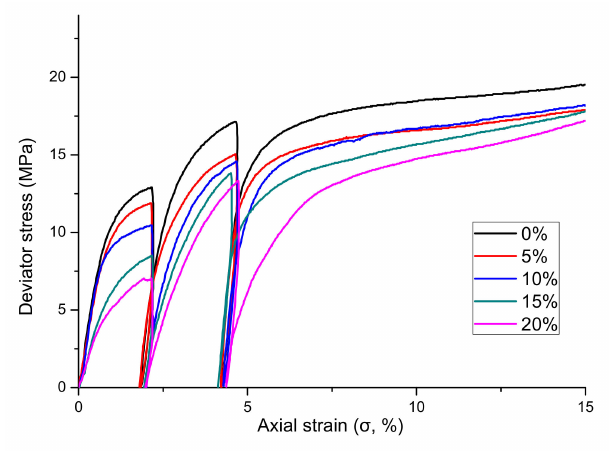
Figure 3. Stress–strain curves by clay content (%). The first stage represents axial strain rates of 0–2.2%, the middle stage accounts for rates of 2.2–4.7%, and the final arc represents strain rates of 4.7–15%. Di ff erent colors correspond to di ff erent clay